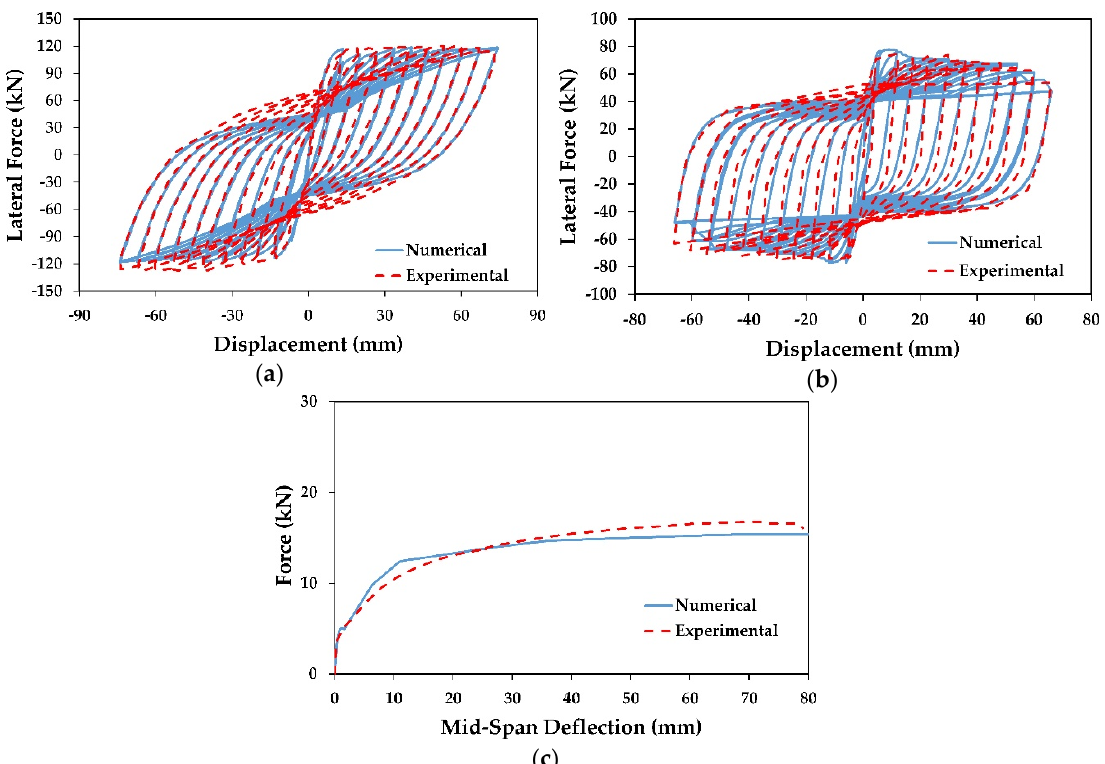
Figure 6. Comparison between the numerical and experimental results: ( a ) B2 column; ( b ) C2-0-3 column, ( c ) beam No.